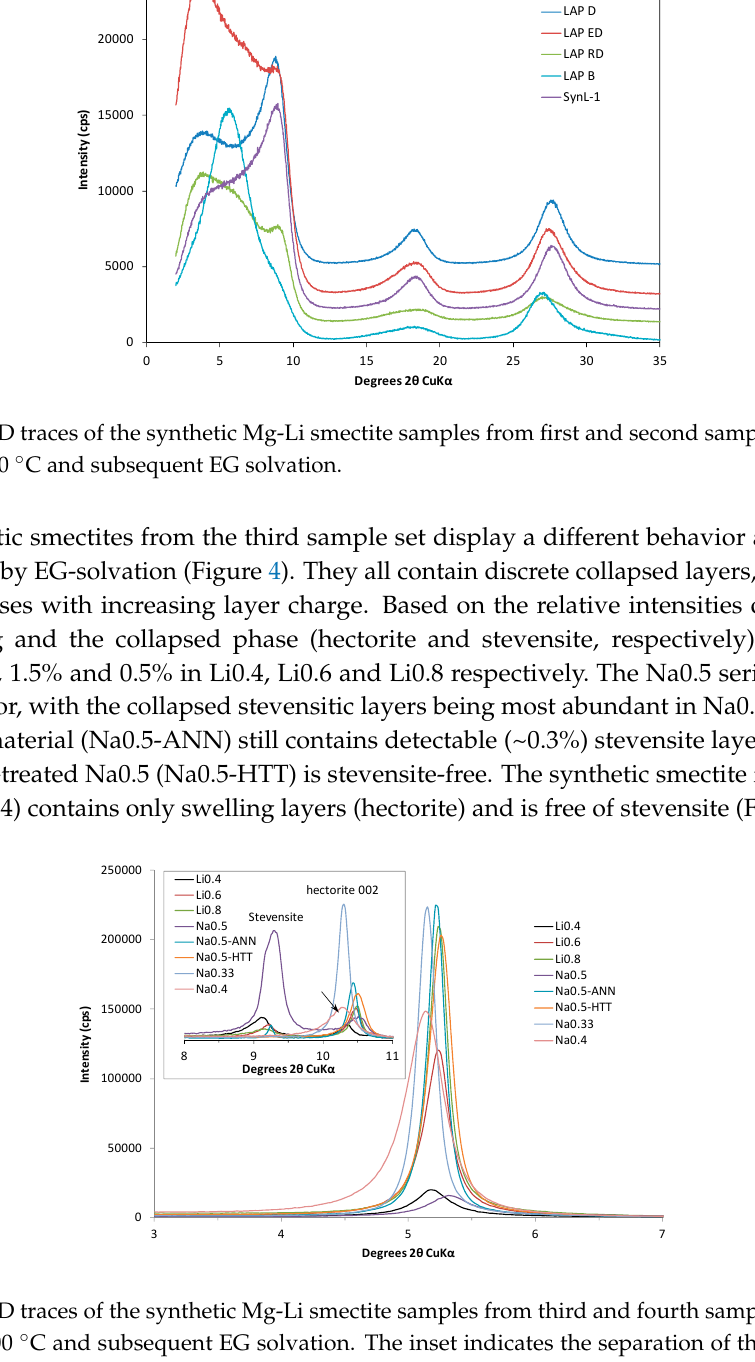
Figure 4. XRD traces of the synthetic Mg-Li smectite samples from third and fourth sample sets after heating at 500 ◦ C and subsequent EG solvation. The inset indicates the separation of the collapsed (stevensite) layers from the 002 diffraction maximum of hectorite. The arrow in the inset indicates sample Na0.4 (fourth sample